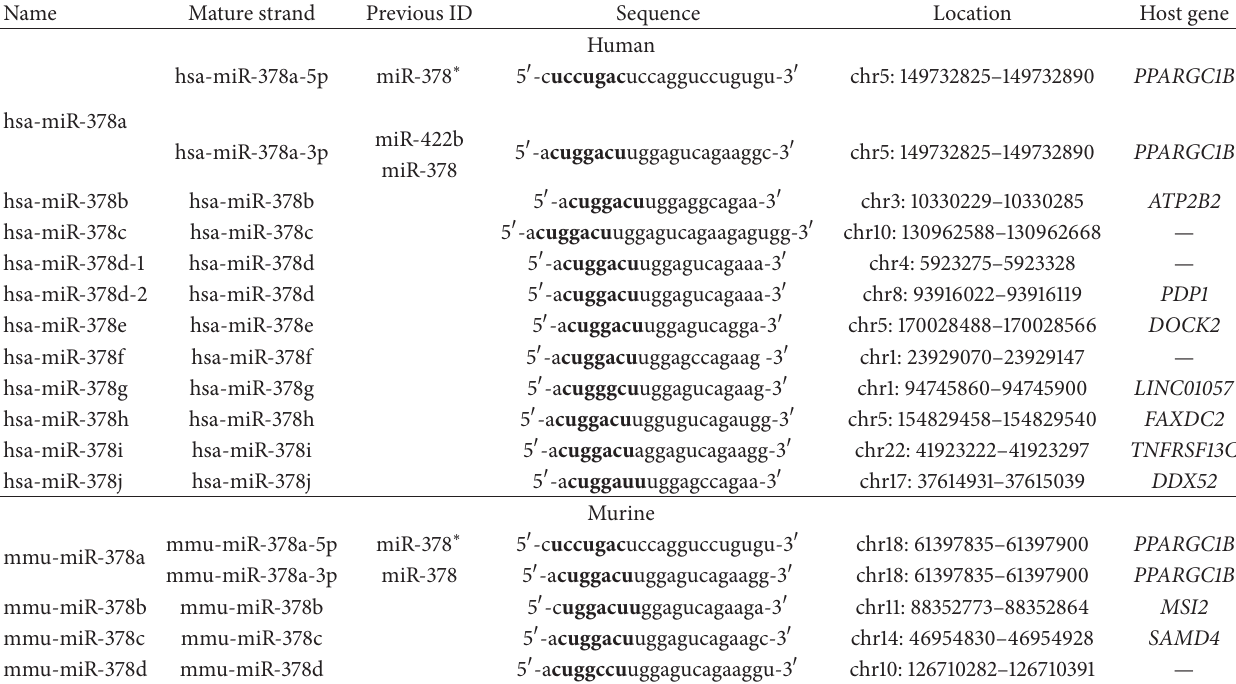
Table 1: Classification of miR-378 variants. Source: miRBase, version 21, September 2015 [28]. The seed sequence (defined as nucleotides 2–8 from the miRNA 5 󸀠 -end of the mature miRNA) is in bold